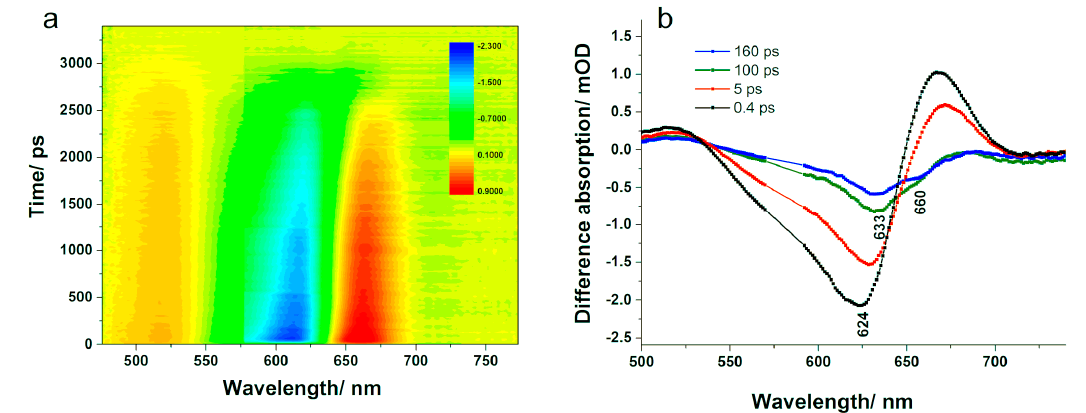
Figure 8. ( a ) Three-dimensional differential absorption signal as a function of probe wavelength and delay time, obtained when the phycobilisome was pumped at 580 nm; ( b ) transient absorption difference spectra recorded at various delay times.